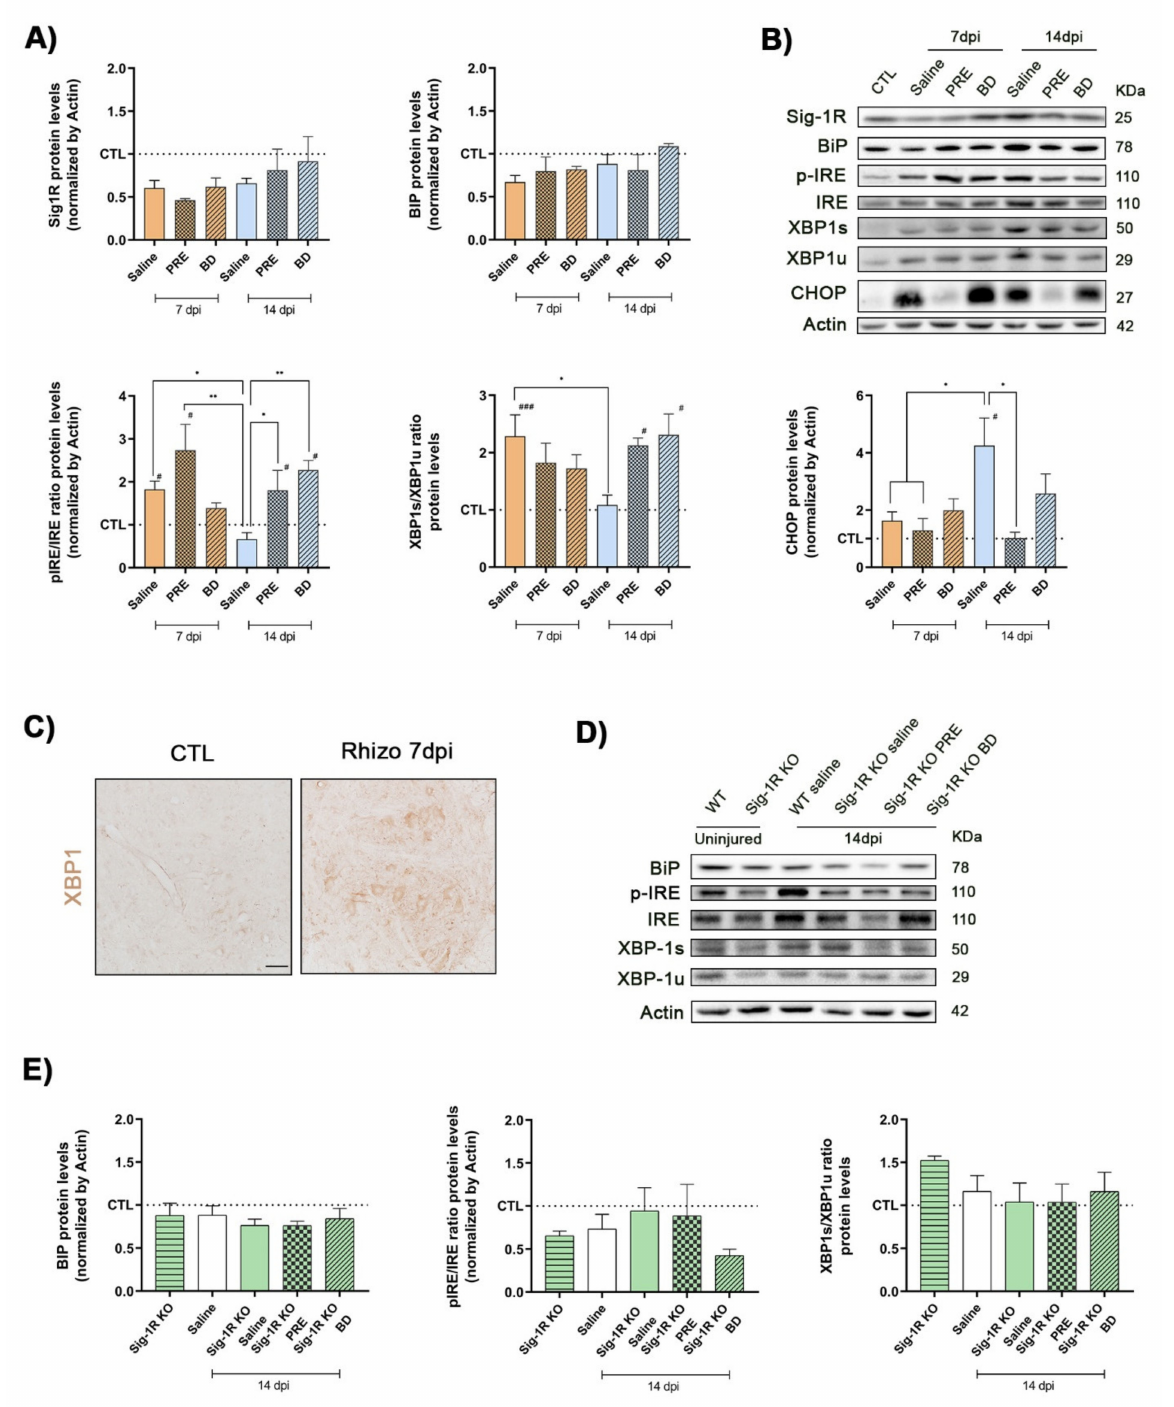
Figure 5. Changes in ER stress markers after rhizotomy. ( A ) Quantitative bar graphs and ( B ) immunoblots and of Sig-1R, BiP, phosphorylated IRE α /IRE ratio, XBP-1s/XBP-1unspliced ratio and CHOP proteins in control (CTL) and in injured mice with or without treatment with PRE-084 and BD1063 at 7 and 14 dpi. n = 3–4 per group and time point. Data are mean ± SEM and analyzed with One-way ANOVA and Dunnett’s multiple comparisons test. ### p < 0.001 vs. CTL mice; ** p < 0.005, * p < 0.05 vs. saline 14 dpi. ( C ) Microphotographs of XBP-1 labeling in the ventral horn of spinal cord confirms the upregulation of this ER stress marker in MNs at 7 dpi. Scale bar 50 µ m. ( D ) Immunoblots and ( E ) bar graphs of BiP, phosphorylated IRE α /IRE ratio and XBP-1s/XBP-1unspliced ratio, in WT and Sig-1R KO mice groups at 14 dpi. n = 3–5 per group. One-way ANOVA and Dunnett’s post-hoc test: # p < 0.05 vs. CTL